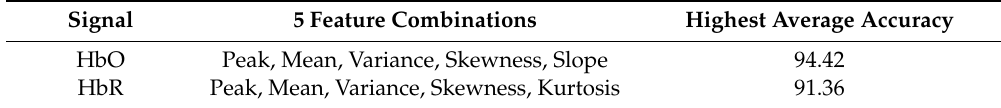
Table 6. The highest classification accuracy of the 5-feature combination.